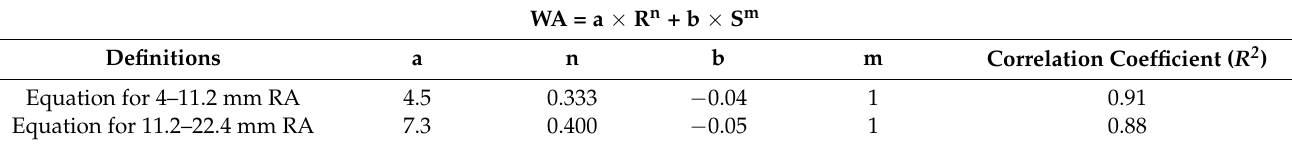
Table 4. The equations for 4–11.2 mm and 11.2–22.4 mm RAs.